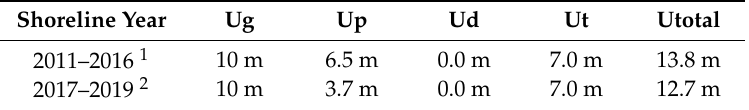
Table 3. Shoreline uncertainty.